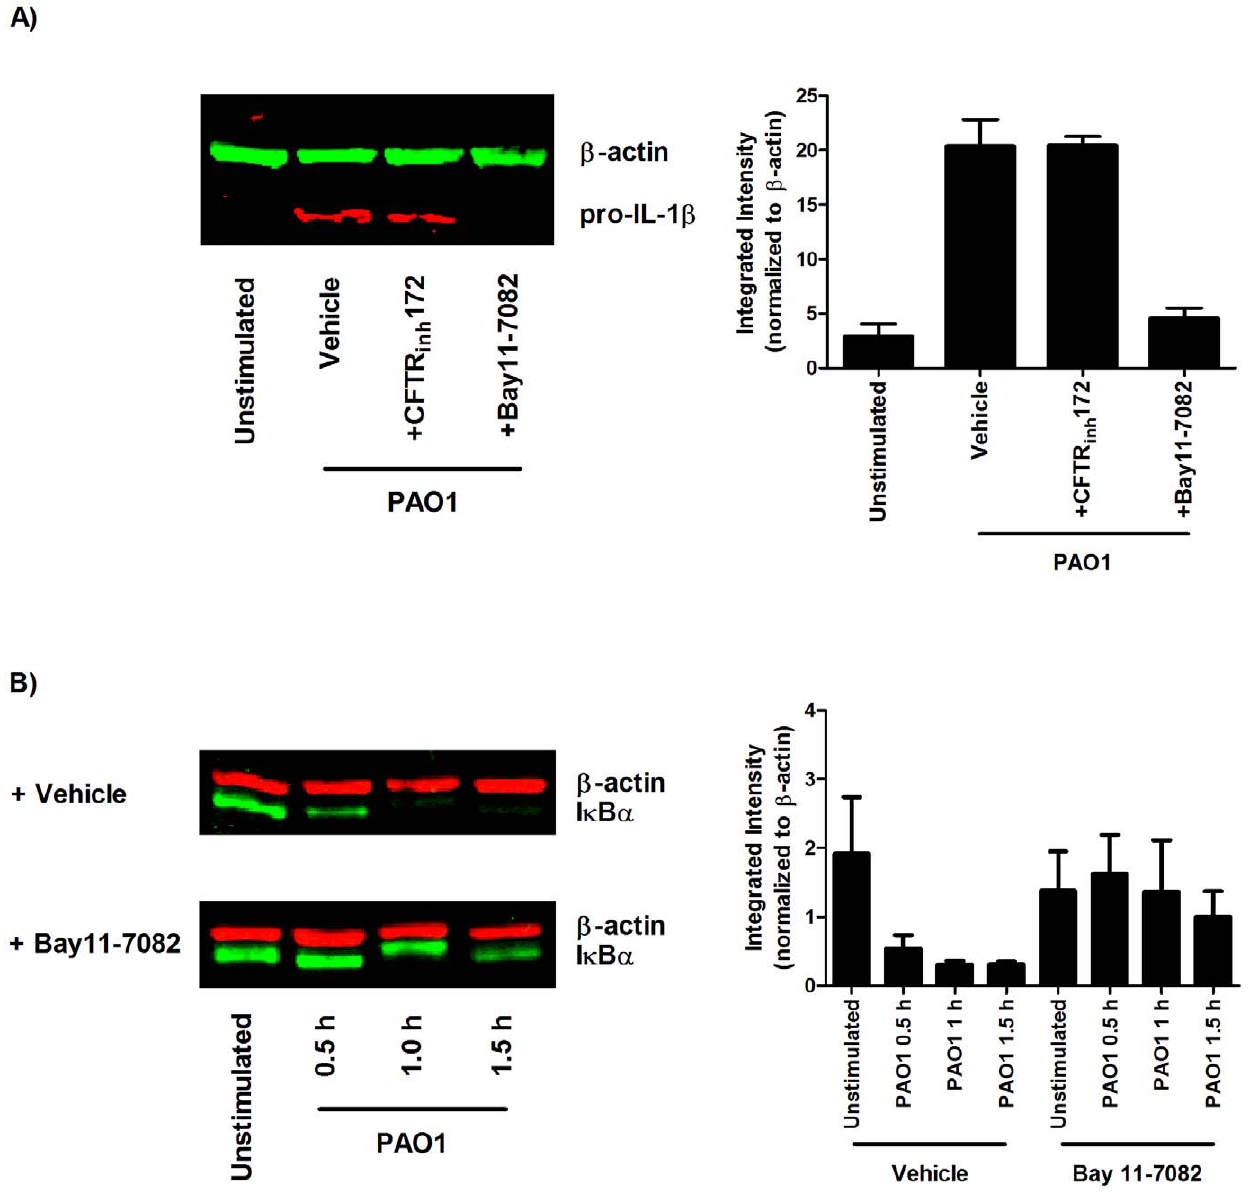
Figure 7. Bay11-7082 inhibits pro-IL-1 b production in response to P.aeruginosa . PMA-differentiated THP-1 cells were treated with 10 m M CFTR inh 172 or 20 m M Bay11-7082 and harvested after (A) 4 hours (n=3) or (B) 0.5, 1, and 1.5 hours (n=3) stimulation with PAO1. One representative blot is shown with a graph of the averaged fluorescence intensity values over 3 experiments.